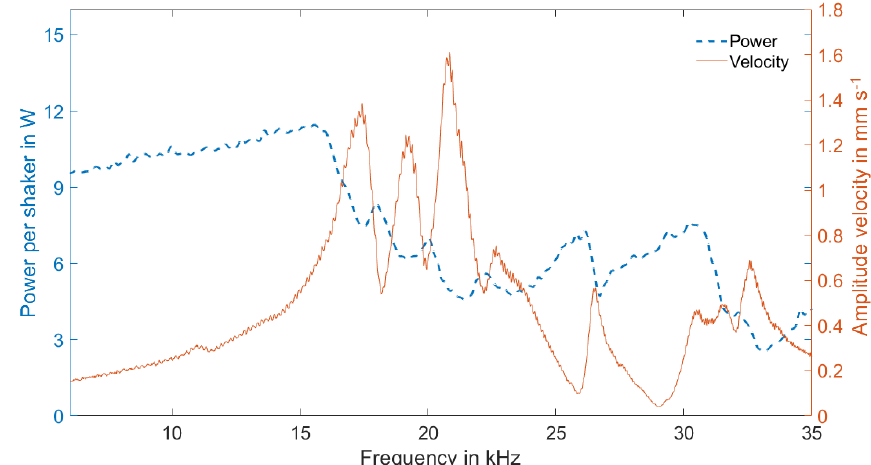
Figure 5. Electric power of the amplifier (blue) and specimen amplitude velocity (red) dependent on the excitation frequency.